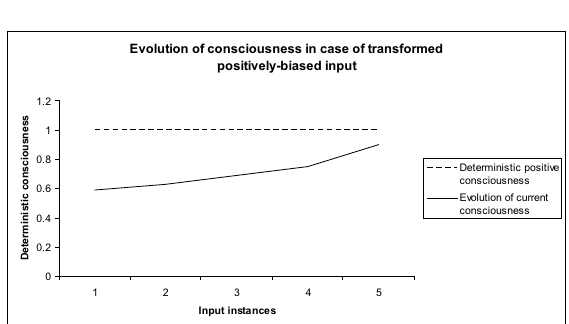
Fig. 25. Variation consciousness in system with transformed excitation (+biased C2).